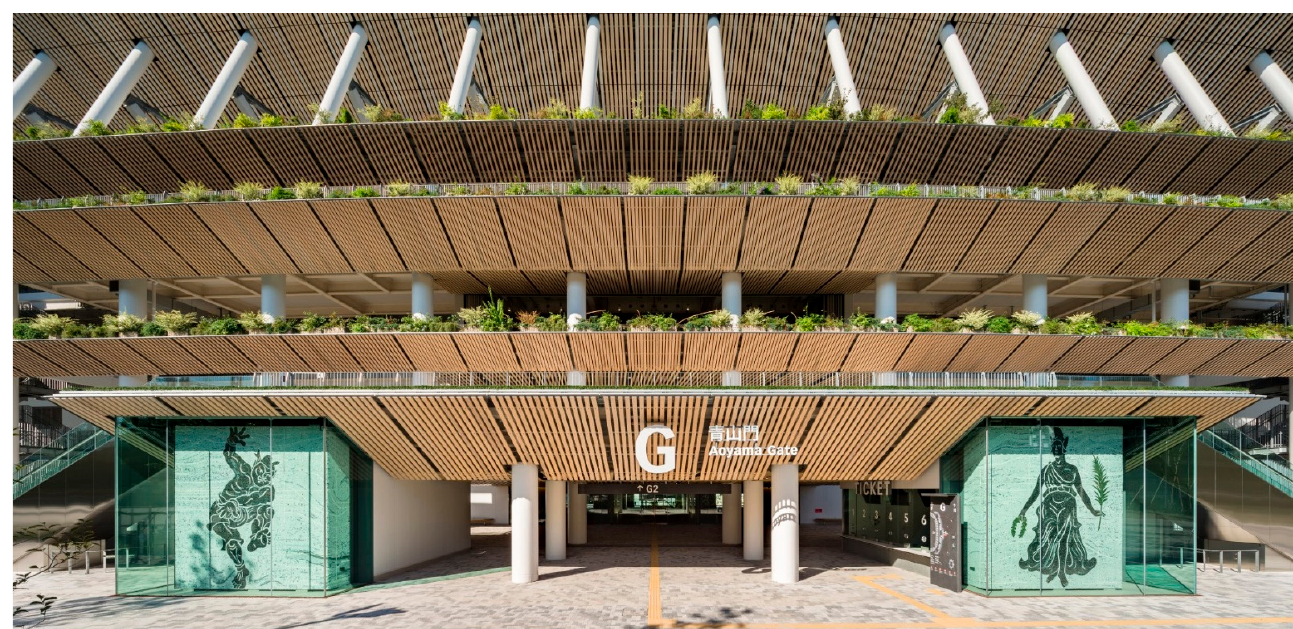
Figure 4. The dismantling of Hasegawa’s Nomi no Sukune mosaic at the former National Stadium, 2016. Reproduced with permission from Kimitaka Takeichi, reprinted from The Mainichi Newspa- pers.